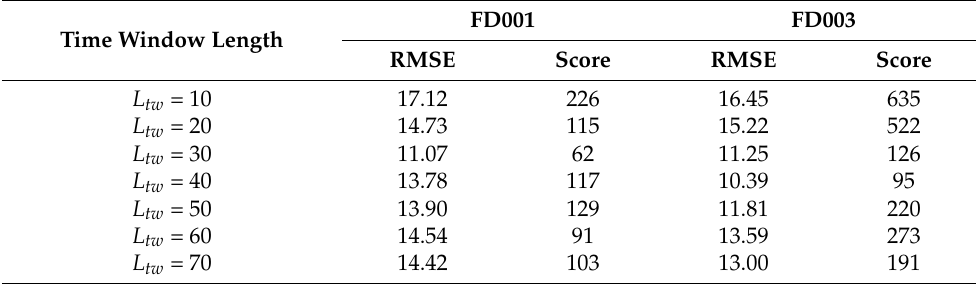
Table 3. Effect of different time-window